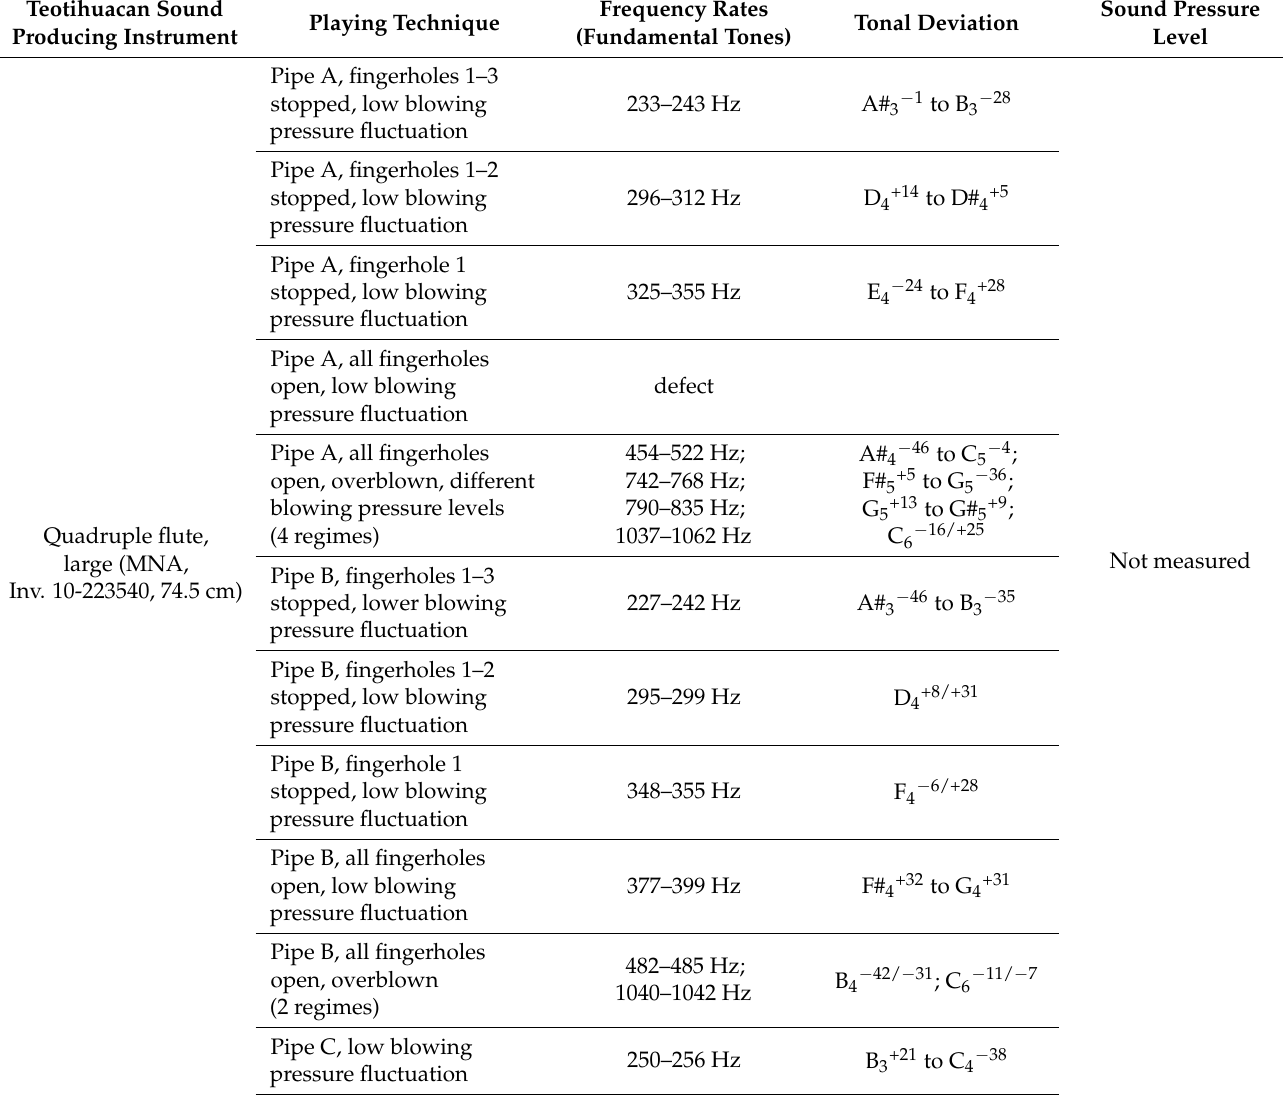
Table 4. Acoustic data sheet of the Zacuala Palace quadruple flute (MNA, Inv. 10-223540). Teotihuacan